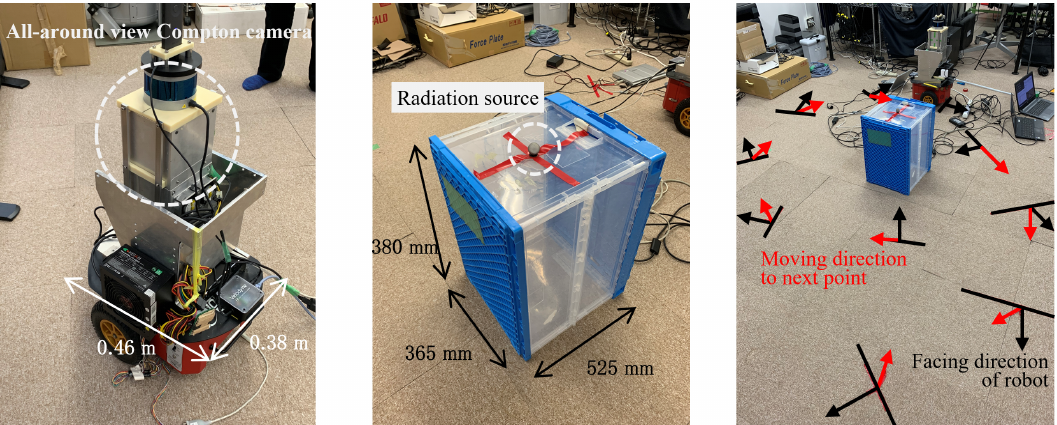
Figure 19. Experimental setup: pioneer-3DX was adopted as the mobile robot, and the all-around view Compton camera was mounted above the mobile robot. A single radiation source is expected in the environment. In the right figure, the red line represents the measurement points determined by the proposed